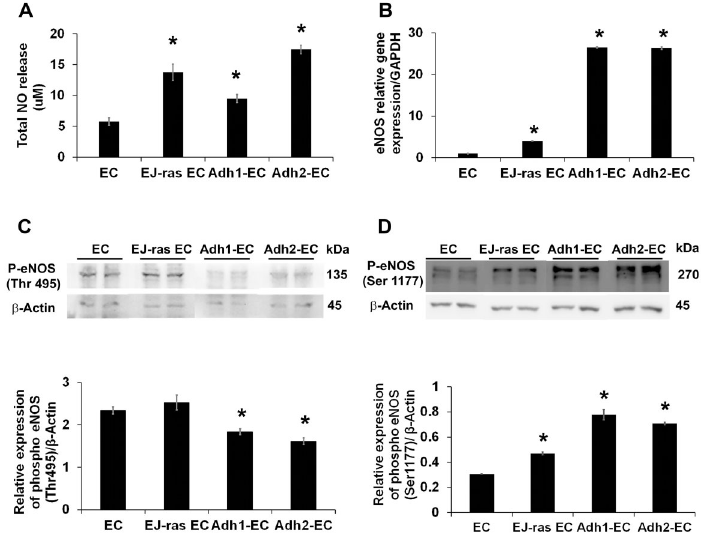
Figure 1. Nitric oxide (NO) release and endothelial nitric oxide synthase (eNOS) expression in EC-derived cell lines. A , NO release by EC, EJ-ras EC, Adh1-EC, and Adh2-EC cells. Data were evaluated by NO-analyzer chemiluminescent method. Experiments were performed in duplicate. B , Gene expression of eNOS detected by qPCR. GAPDH was used as a loading control. C , Protein expression of monomeric eNOS (135 kDa) phosphorylated at threonine 495 (Thr495). D , Protein expression of dimeric eNOS (270 kDa) phosphorylated at serine 1177 (Ser1177). The experiments were performed in duplicate and repeated twice. EC: parental endothelial cells; EJ-ras EC: EJ-ras transfected endothelial cells; Adh1-EC and Adh2-EC: anoikis-resistant endothelial cells. Data are reported as means ± SE. *P o 0.05 compared to EC